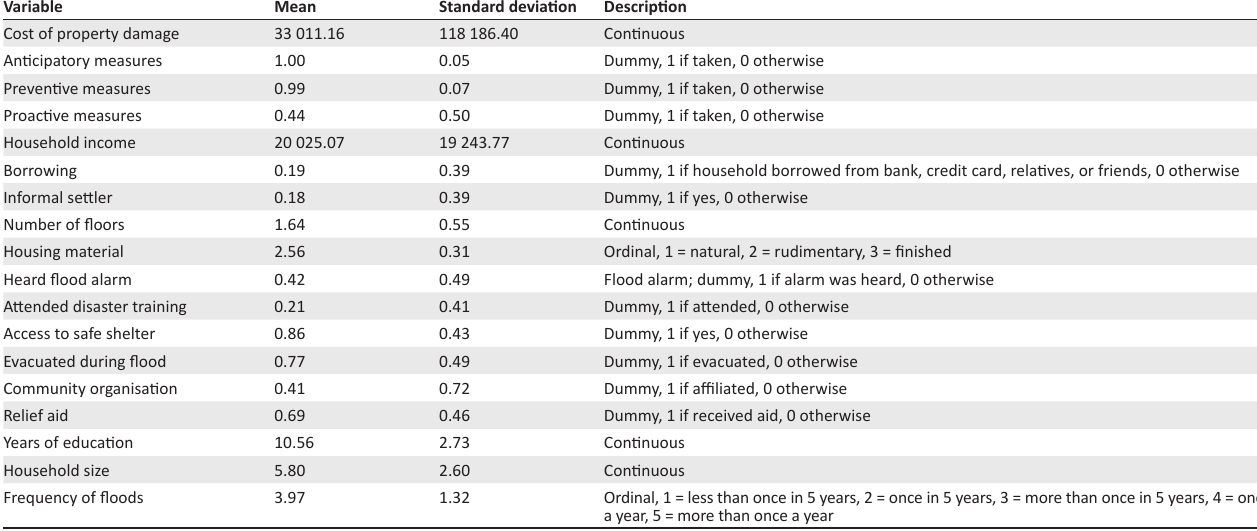
FIGURE 1: Timeframe in which respondents repaired or replaced damaged property. TABLE 8: Description of variables for interval regression model.